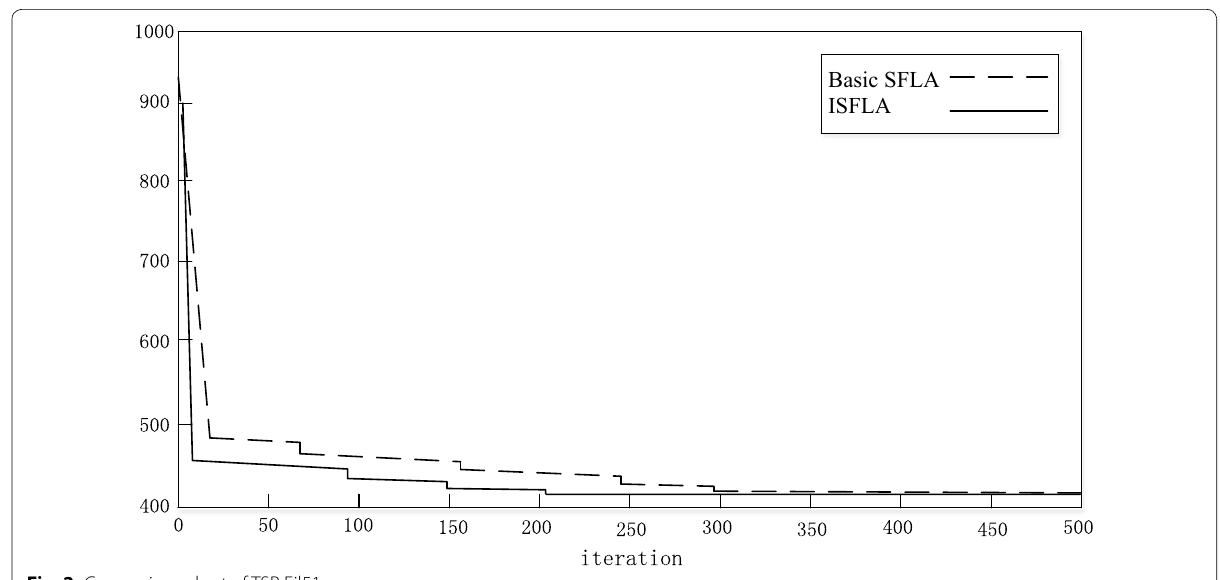
Fig. 2 Comparison chart of TSP